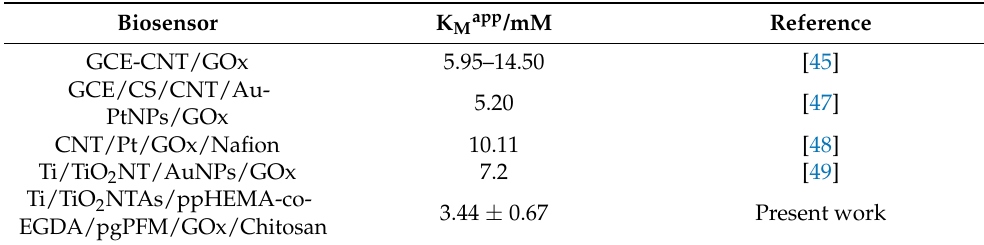
Table 2. Values of the apparent Michaelis–Menten constant of different glucose biosensors de- scribed in the literature and of the Ti/TiO 2 NTAs/ppHEMA-co-EGDA/pgPFM/GOx/Chitosan biosen- sor developed in the present work. The value shown in the present work is the average value and its deviation obtained from three different biosensors.